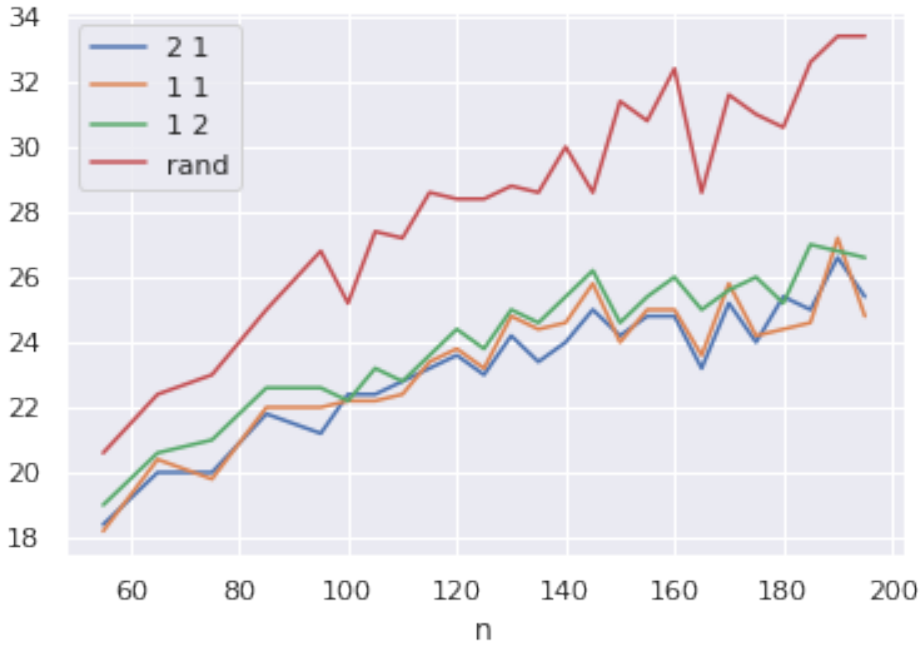
Figure 6. Average number of nodes in a minimal (1,2)-dominating